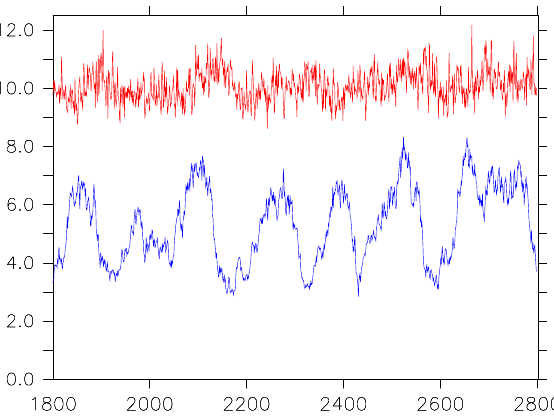
Fig. 16. The annual mean Arctic (red) and Antarctic (blue) sea ice volume in 10 12 m 3 during the 1000-year control run.